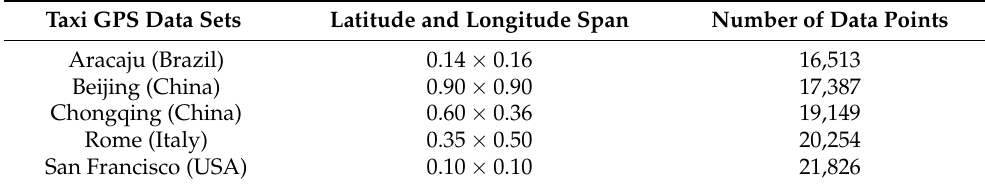
Table 3. Summary information of Taxis GPS data sets. Taxi GPS Data Sets